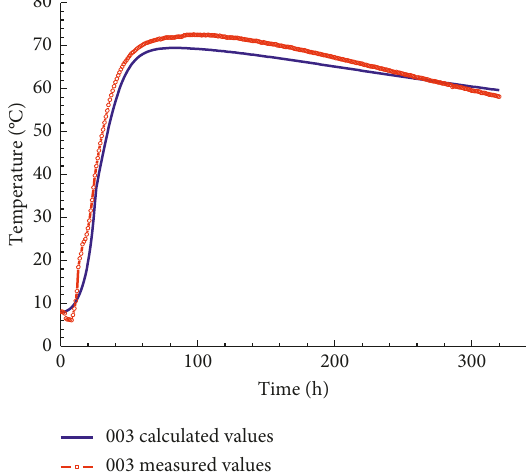
Figure 14: Comparison between the calculated and measured values for Point 003.